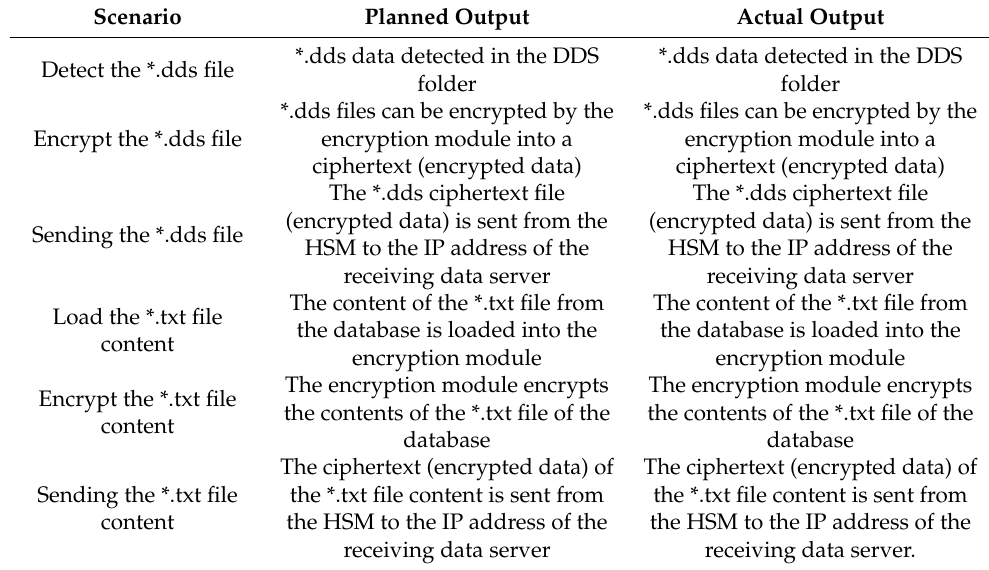
Table 4. Data encryption and transmission testing.